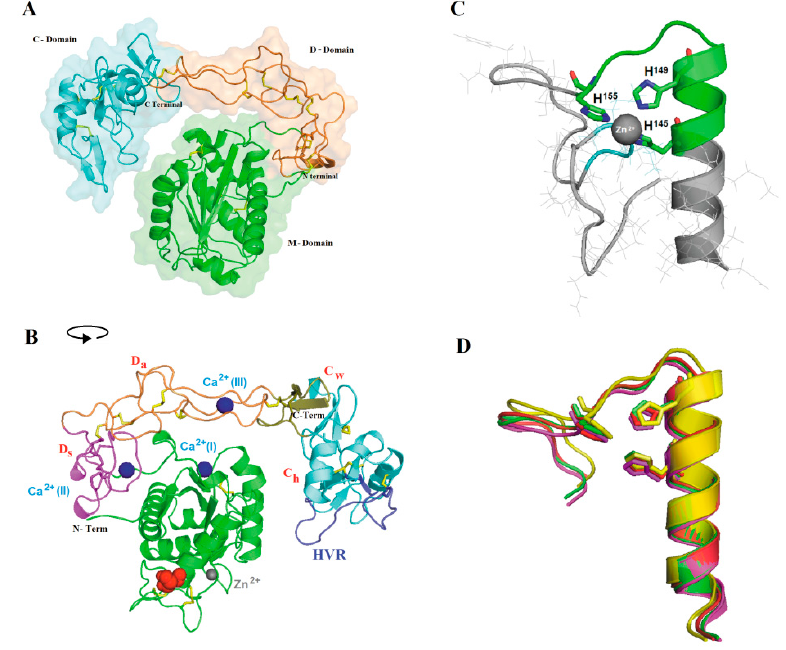
Figure 3. Theoretical Atroxlysin-III 3D model. ( A ) A homology model of Atr-III generated with Modeller 9.13 using crystal structures of other P-III SVMPs as templates. The metalloproteinase (M), disintegrin-like (D) and Cysteine-rich (C) domains are indicated by green, orange, and cyan colors, respectively. Elements of secondary structure α -helices, β -structures, N- and C-terminal ends are presented. Disulfide bonds are in yellow sticks. ( B ) Principal motifs of Atr-III according to Igarashi et al. [34]. The M-domain, Ds, Da, Cw, and Ch segments and the hyper-variable-region (HVR) are shown in green, magenta, orange, olive, cyan, and blue, respectively. Zinc and calcium ions are represented as grey and blue spheres, respectively. N-glycosylation motif is indicated in red spheres. ( C ) Details of the zinc binding site of Atr-III where the positioning of the three histidine residues are shown. ( D ) Superposition of the zinc-binding residues of Atr-III with the P-III SVMPs are shown in sticks and labeled. B. jararaca (red), C. atrox (magenta), and A. acutus (yellow). For interpretation of the references to color in this figure legend, the reader is referred to the web version of this article.